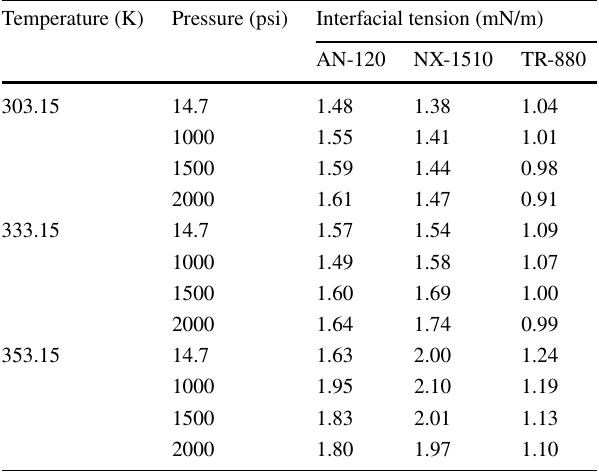
Fig. 10 Dynamic interfacial tension curves of TR-880 solution at a concentration of 50 ppm and salinity from NaCl dissolution at vari- ous concentrations at 351.15 K and 14.7 psi Table 6 Effect of temperature and pressure variations on the interfa- cial tensions of AN-120, NX-1510 and TR-880 surfactants in a con- centration of 500 ppm and KCl at 150,000 ppm with crude oil Temperature